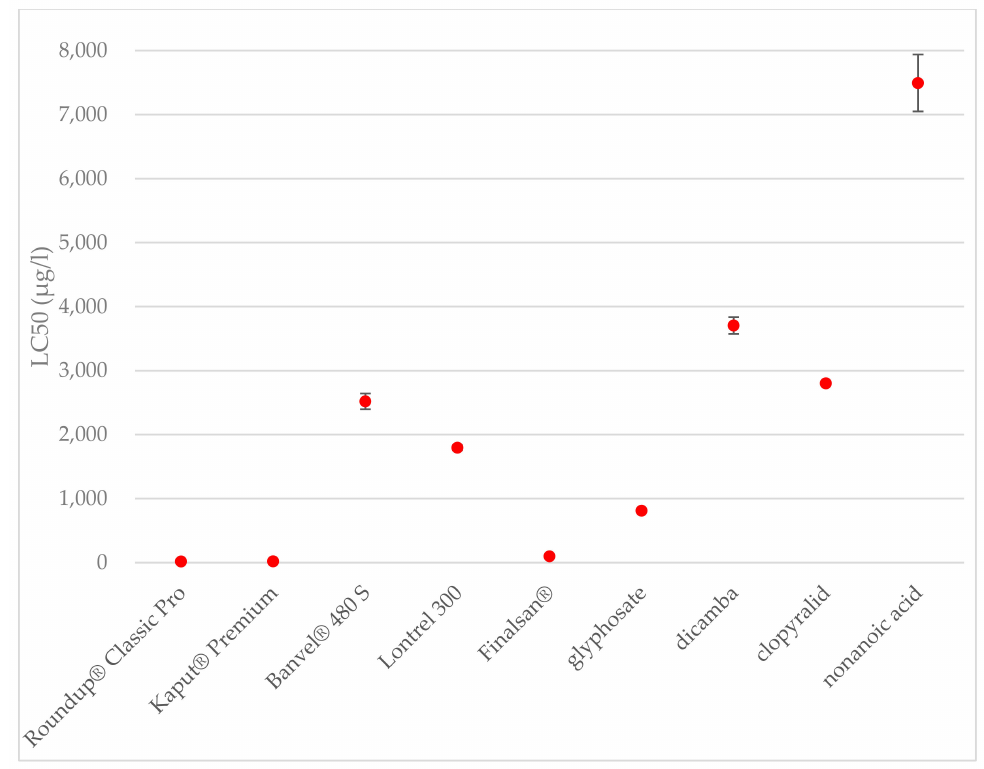
Figure 3. Toxicities of the herbicides and active substances after 24 h of exposure to A. salina . The data are expressed as the mean LC 50 value ± their respective standard